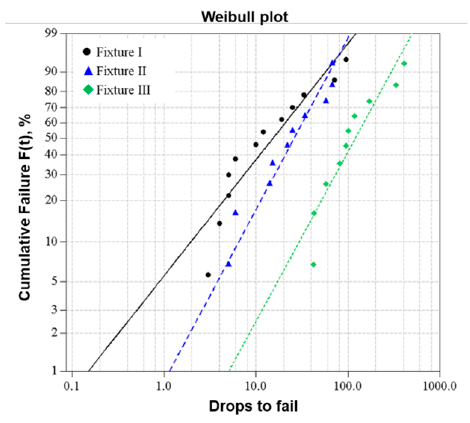
Figure 8. Weibull distribution of the drops to failure for BGA packages ② with various fixtures. Table 2. Analysis of the Weibull distribution plot for BGA package ② .